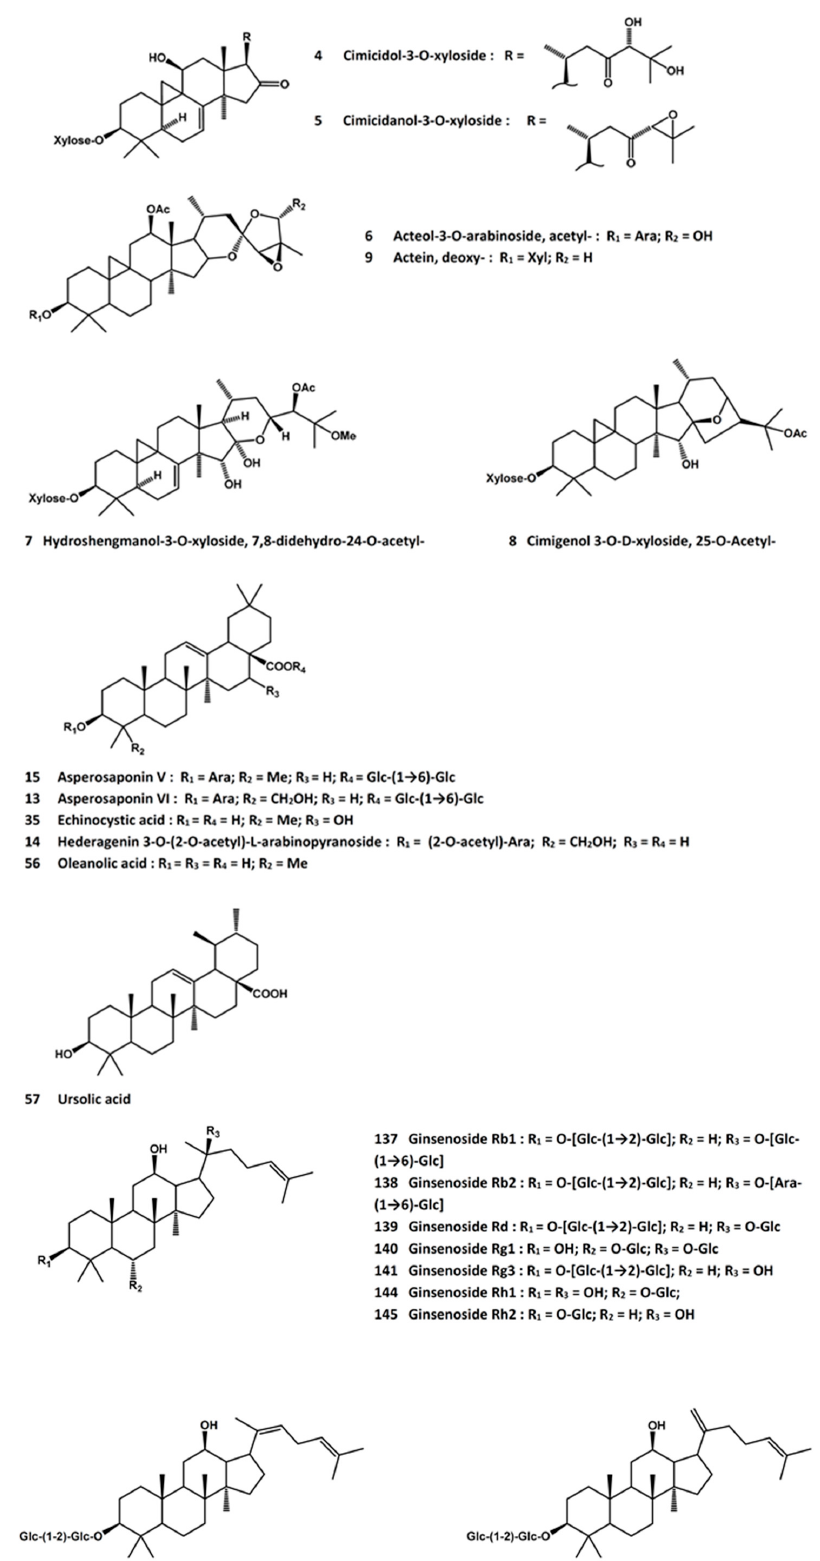
Figure 3. Triterpenoids reported to possess osteoprotective property.